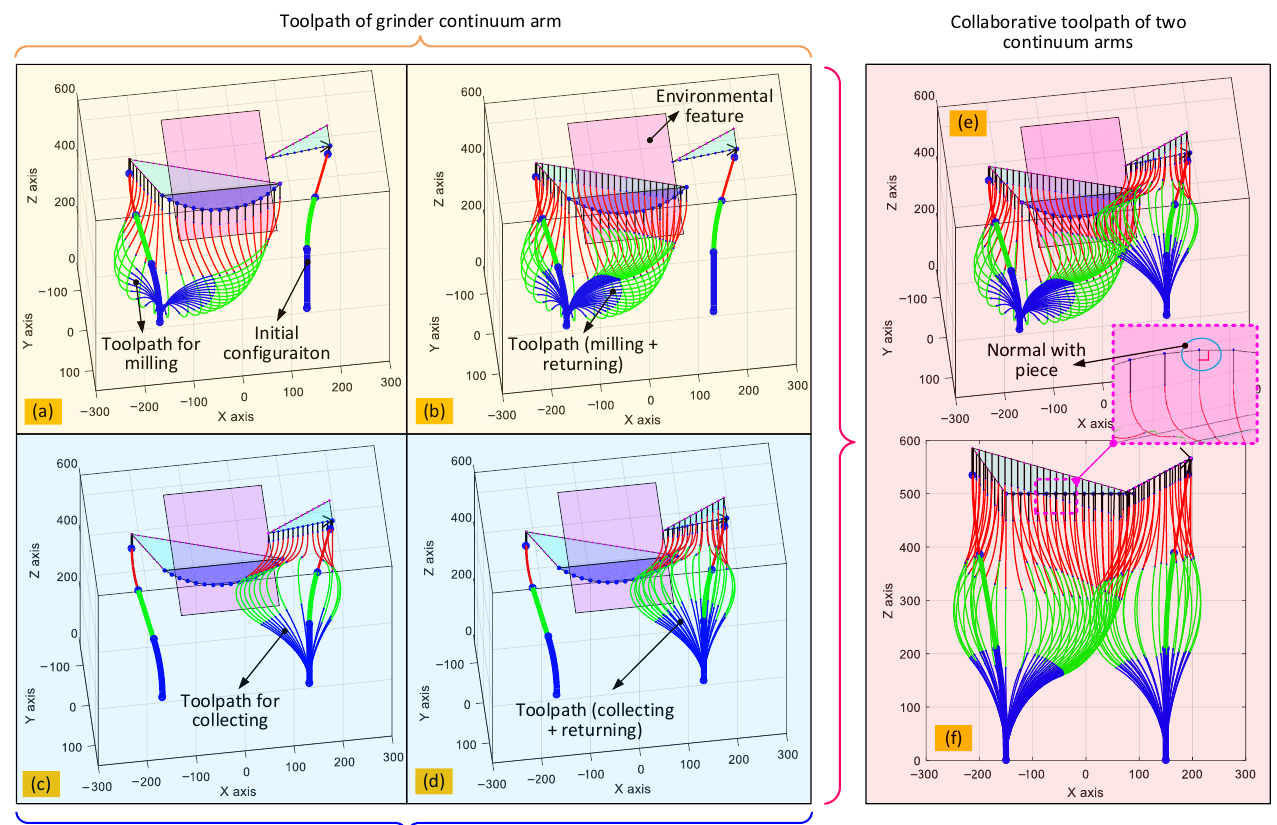
Figure 15. Shape of the collaborative continuum arms during operation calculated proposed optimization-based inverse kinematic algorithm: ( a ) and ( b ) display the shape of the continuum arm with the grinder, ( c ) and ( d ) display the shape of the continuum arm with the gripper, ( e ) and ( f ) show the shape of the two 6-DoF continuum arms working collaboratively. Note: the axis of both end effectors is along the 𝒁 axis in this case study.